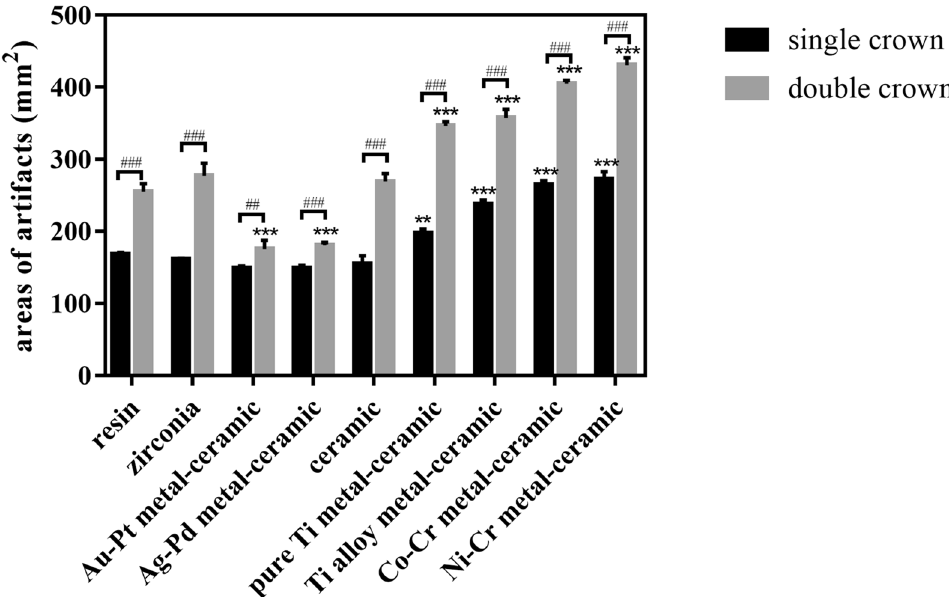
Figure 8. Quantitative analysis of the artifacts produced by the single or double crowns of nine different materials combined with titanium implants and abutments in MRI ( # P < 0.05, ## P ≤ 0.01, and ### P ≤ 0.001 between each group. *, **, and *** indicate significant differences in comparison with the resin group. * P < 0.05, ** P ≤ 0.01, and *** P ≤